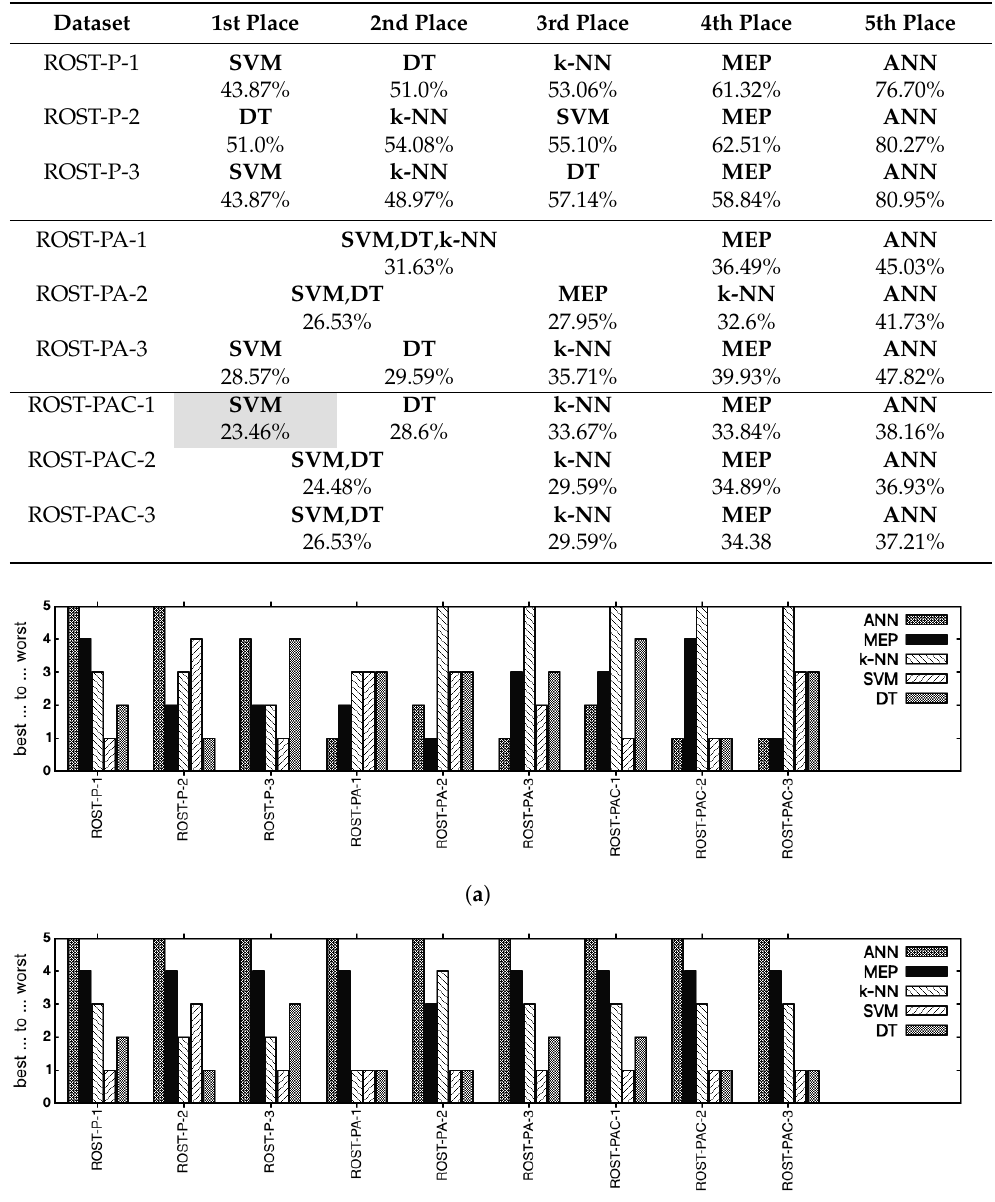
Table 17. Top of methods on average results on each shuffle of each dataset. For k-NN, SVM, and DT we do not have 30 runs with the same parameters, so for these methods, the best values are presented here. The gray-colored box represents the overall best average (i.e., on all datasets and with all methods).